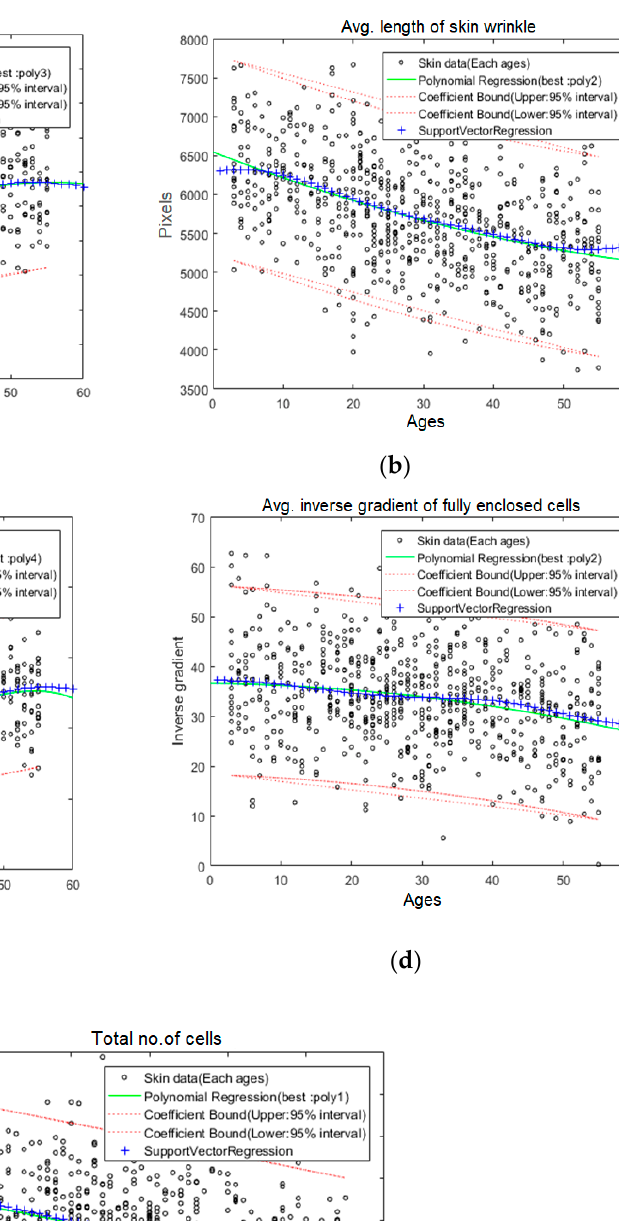
Figure 13. Neck skin texture aging trend estimation using polynomial regression and SVR—( a ) average width trend of neck wrinkle; ( b ) average length trend of neck wrinkle; ( c ) average area trend of fully enclosed neck cells; ( d ) average inverse gradient trend of fully enclosed neck cells; (e) trend of the total number of neck cells.